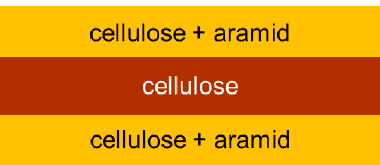
Figure 1. The structure of aramid-enhanced cellulose paper [1].